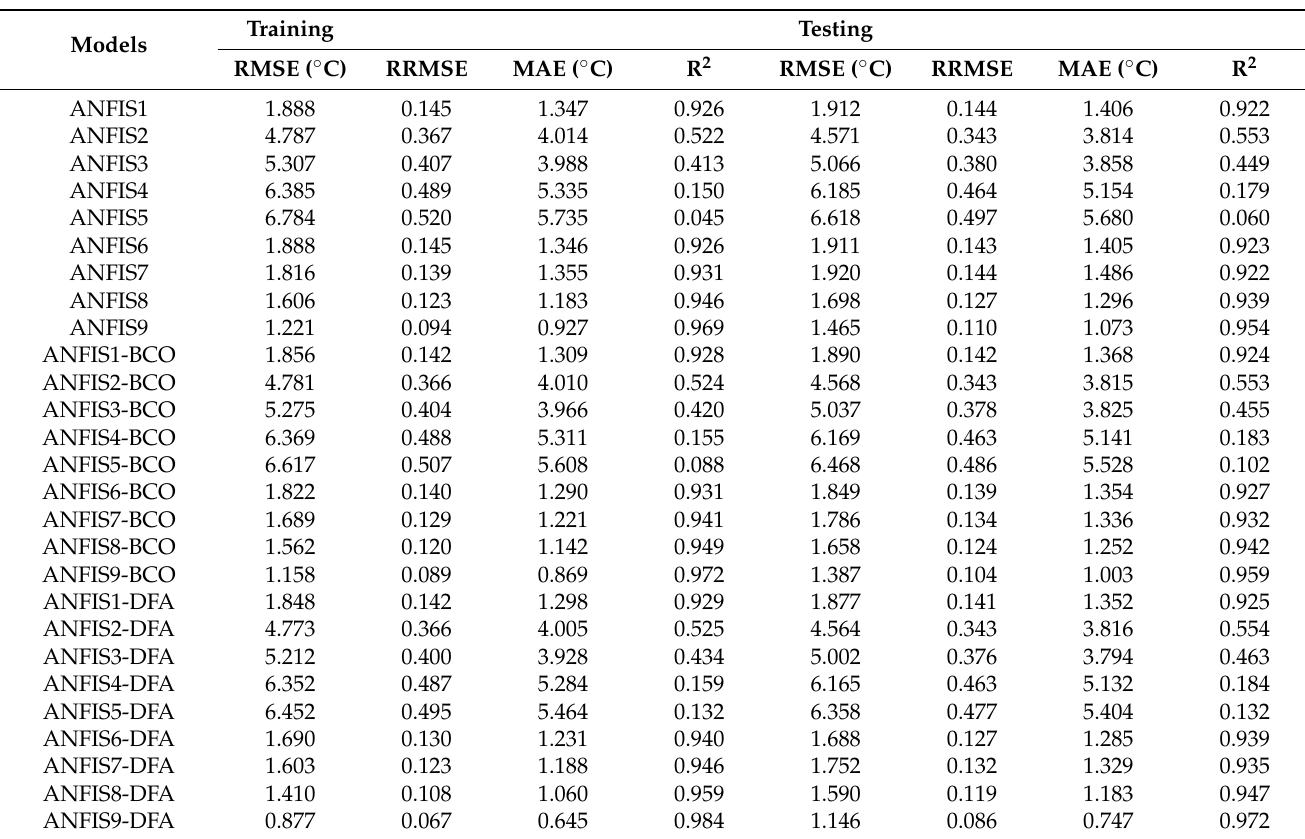
Table 4. Statistical metrics of the RMSE, RRMSE, MAE, and R 2 for the classical and hybrid models developed at the Rasht